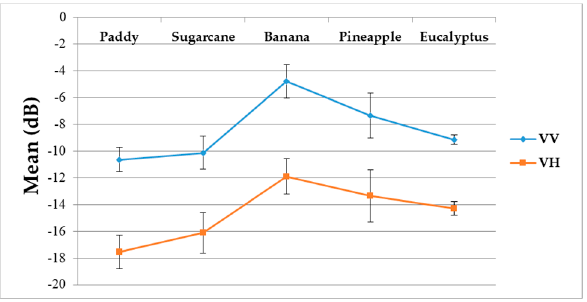
Figure 10. Averages and standard deviations of the backscatter coefficient (dB) of VV and VH polarizations for the five different crop types.